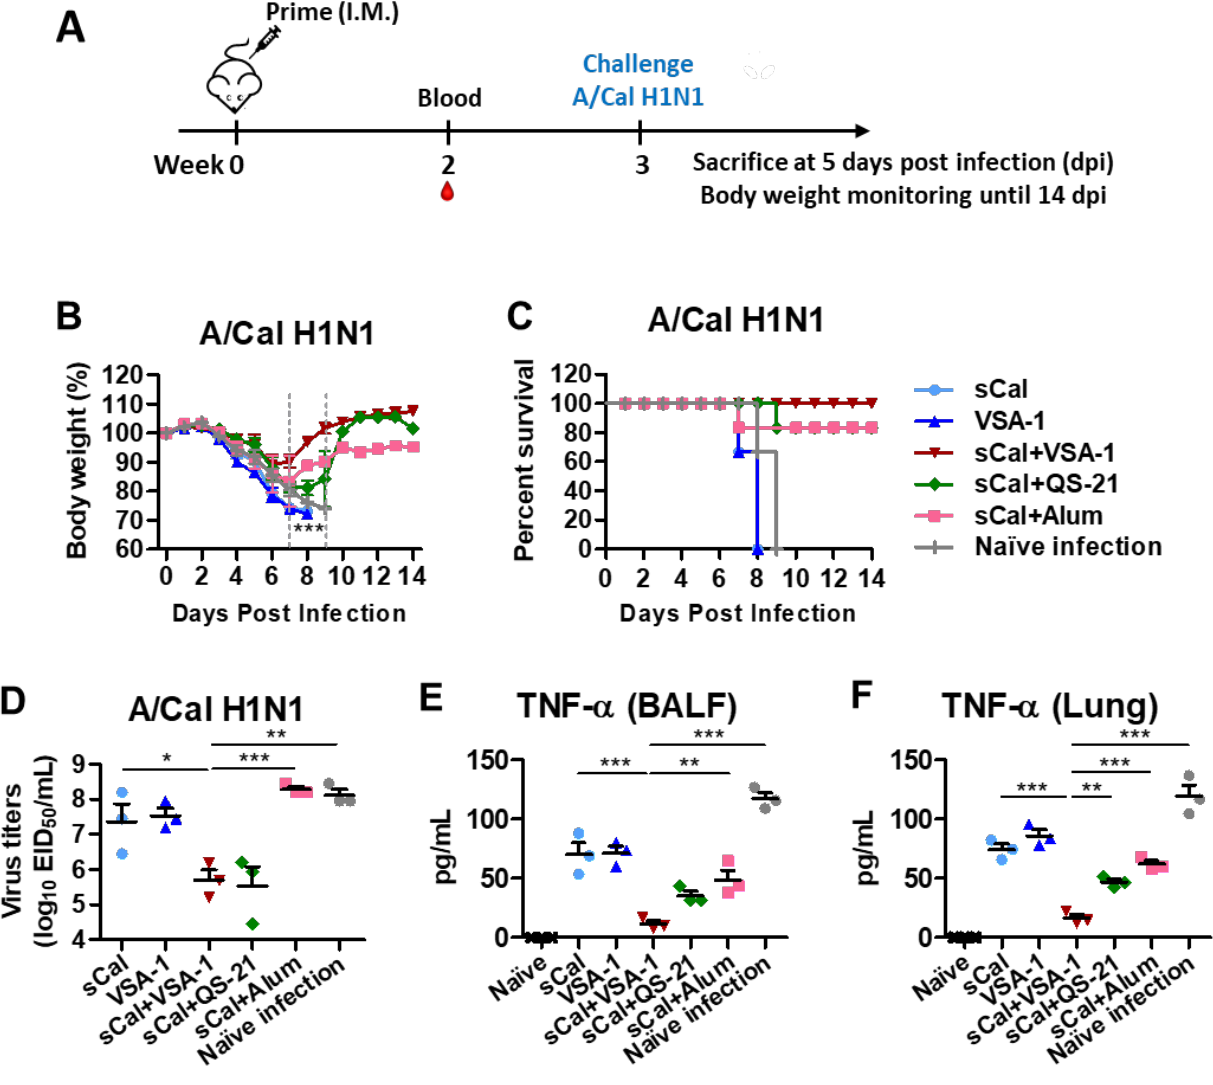
Figure 3. Prime immunization with VSA-1-adjuvanted sCal vaccine confers protection against lethal challenge with homologous A/Cal H1N1 virus. ( A ) Immunization and virus challenge scheme ( n = 6–8 per group). ( B ) Body weight changes and ( C ) survival rates for 14 days ( n = 3–5). ( D ) Lung viral titers ( n = 3) as 50% egg infectious titers (EID 50 ). ( E , F ) TNF- α cytokine levels in BALF and lung extracts. Error bars indicate the mean ± SEM. *; p < 0.05, **; p < 0.01, ***; p < 0.001 compared to the sCal + VSA-1 group.